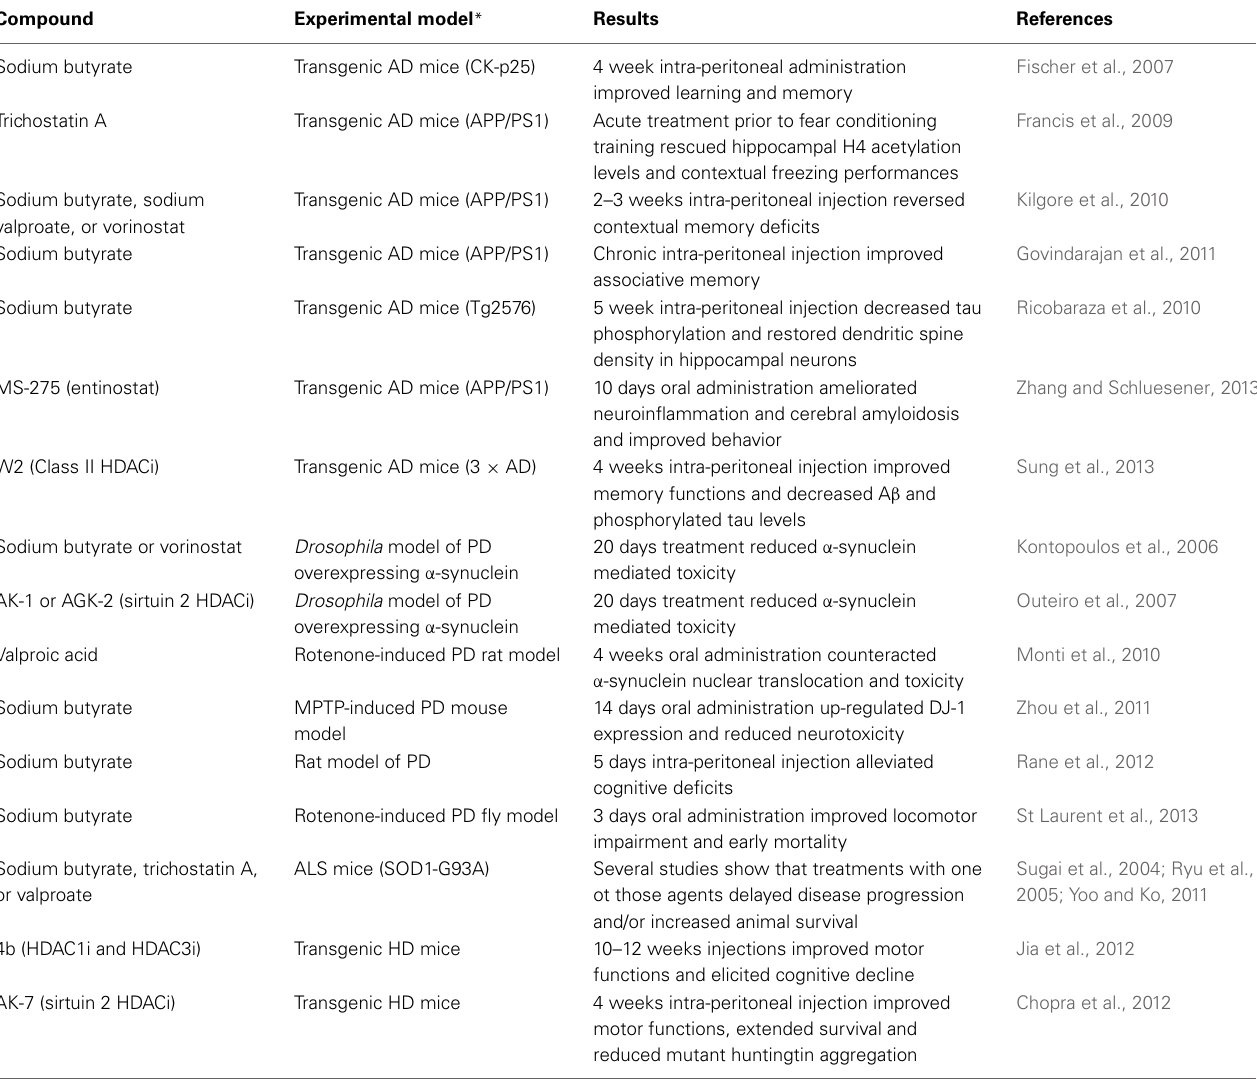
Table 2 | Some examples of the effects of histone deacetylase inhibitors (HDACi) in animal models of neurodegenerative